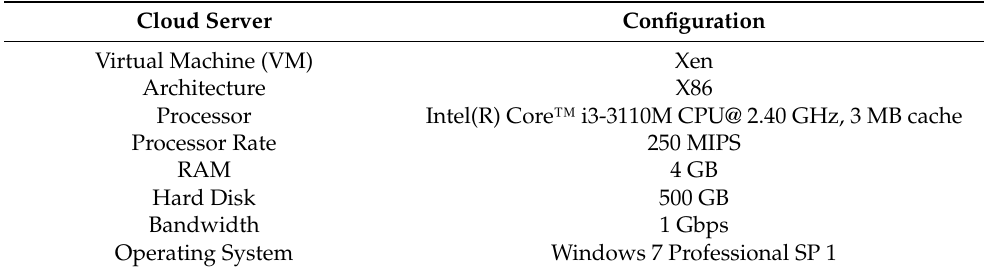
Table 4. Configuration details of cloud